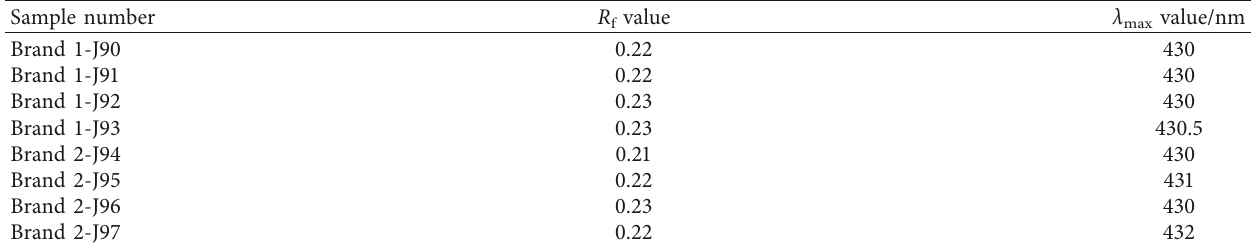
Table 1: TLC and spectrophotometric analysis of nonpermitted dye in “instant red jelly” samples. Sample number